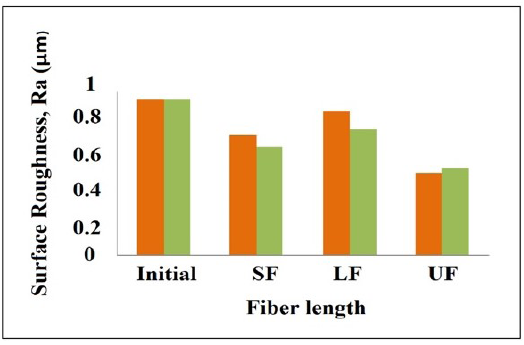
Figure 3. Influence of the fiber length on surface roughness.